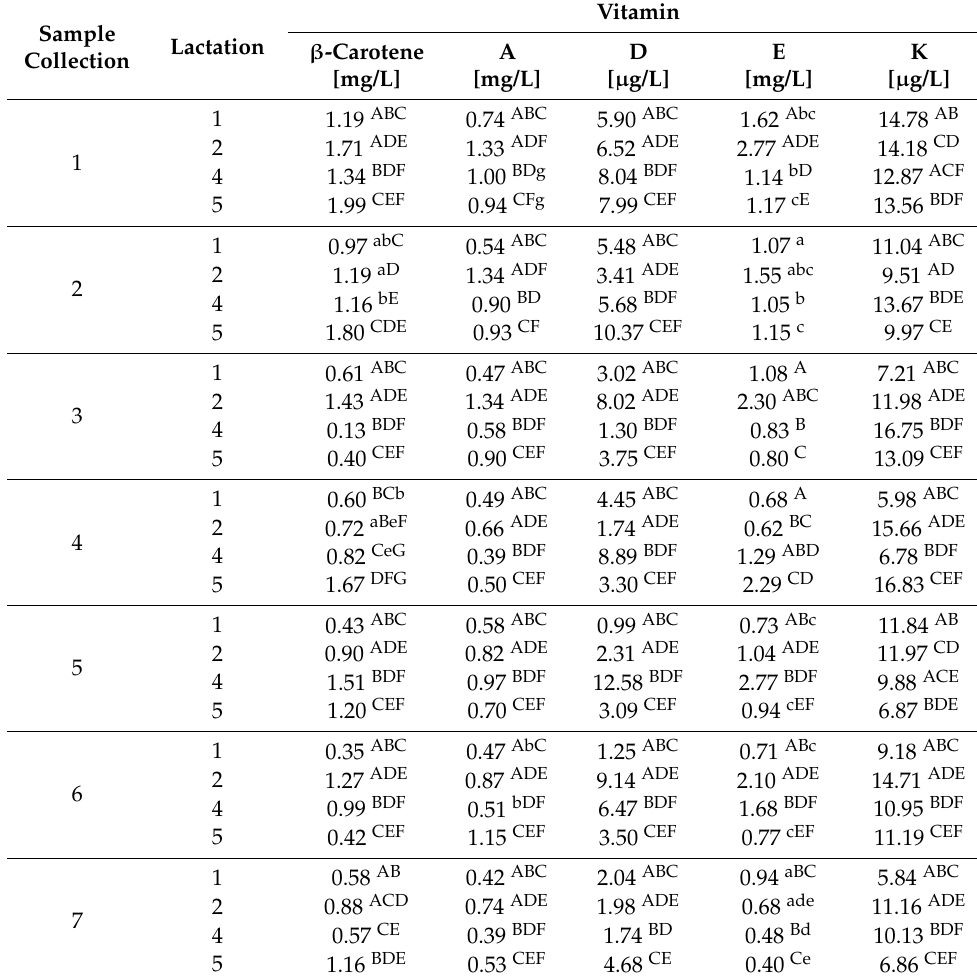
Table 4. Changes in vitamin values in colostrum for subsequent collections, depending on parity. Data are presented as least squares means. Means marked with the same letters differ significantly at: lowercase letters, p ≤ 0.05; uppercase letters, p ≤